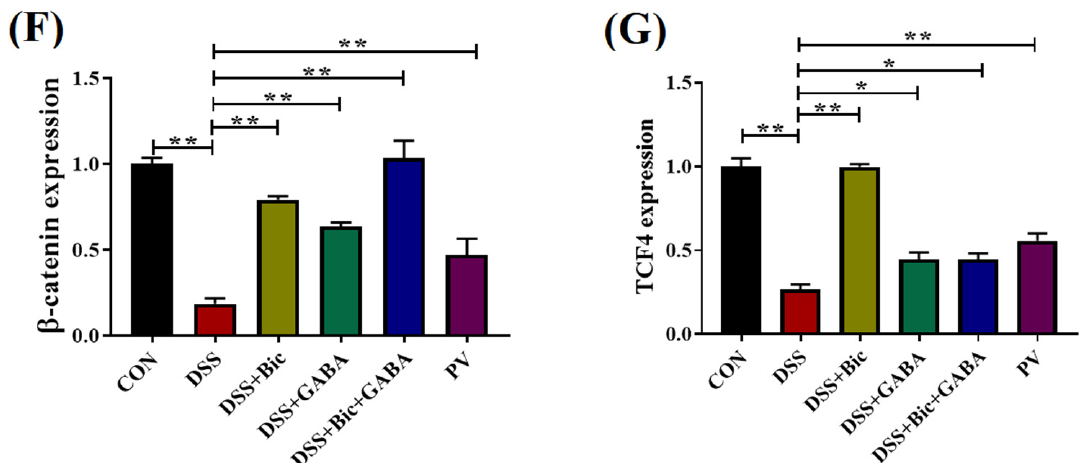
Figure 4. Expression levels of Wnt signaling pathway − associated proteins and PCNA in colon tissues of DSS − induced mice. ( A ) Representative pictures of colon tissue stained by immunohistochemistry with anti − PCNA (brown). Arrows point towards the PCNA signal. ( B ) Statistical analysis of PCNA expression. ( C ) GABA A R, PCNA, β− catenin, and TCF4 expression in the mouse colon was determined by Western blot. β− Actin was used as loading control. ( D – G ), Quantitative analysis of GABA A R, PCNA, β− catenin, and TCF4 protein levels by ImageJ ( n = 6 per group). Data are presented as mean ± SEM. * p < 0.05, ** p < 0.01. NS indicates no significant change.